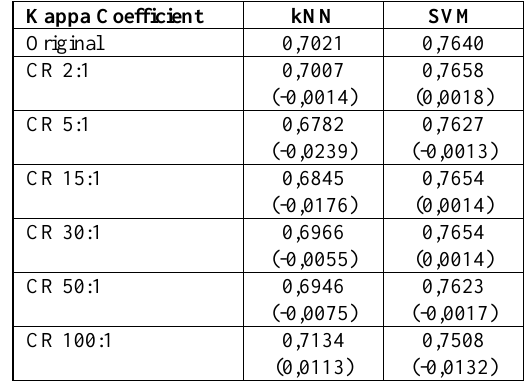
Table 2. Kappa coefficient of the original and